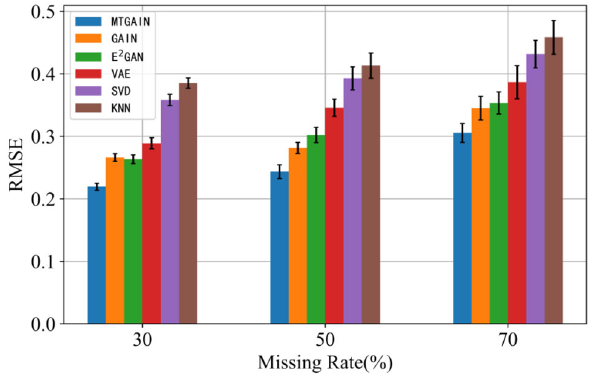
Fig. 8 RMSE comparisons in structural missing